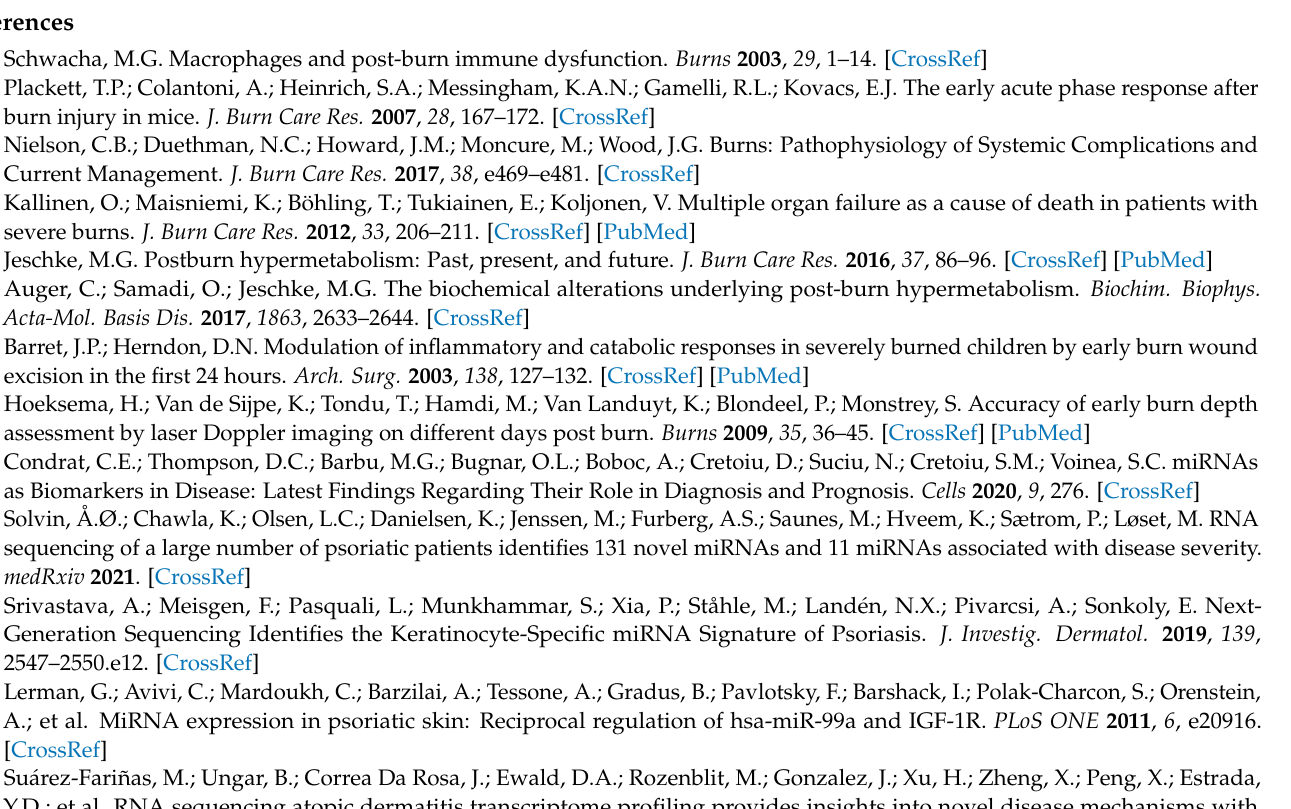
(blue). Table S1: miRNAs with the number of interactions based on 2 different tools that were considered as putative early burn response regulators. Table S2: Selected miRNAs for gene expression analysis. Table S3: TaqMan assays used for gene expression analysis with